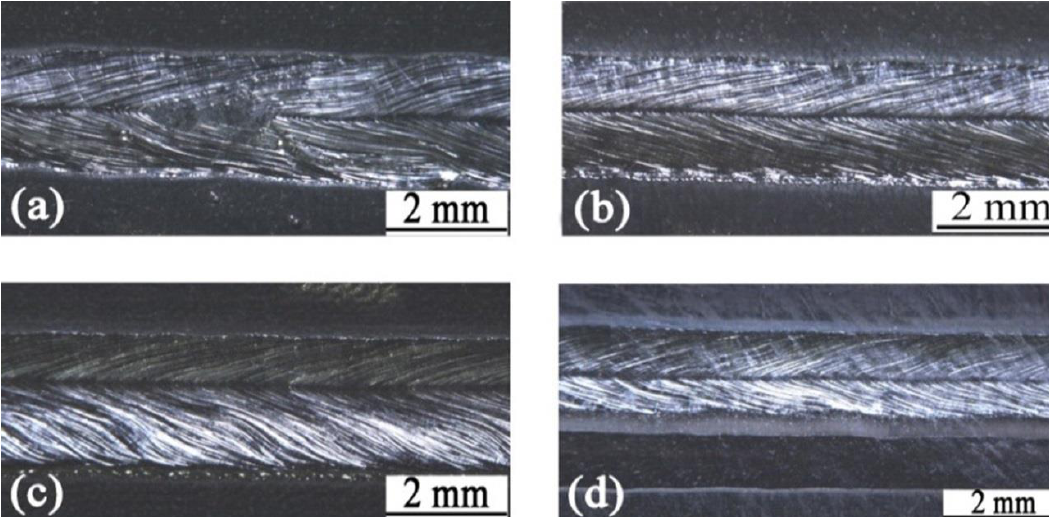
Figure 4. Effects of d 1 on the weld appearances of steel/Al joints produced by using dual-beam laser welding with side-by-side configuration while the Rs of 1.5, the P L of 3000 W, the v of 33 mm/s, and the Δ Z of 0 mm were fixed: ( a ) 0.5 mm; ( b ) 1.0 mm; ( c ) 1.5 mm; ( d ) 2.0 mm.